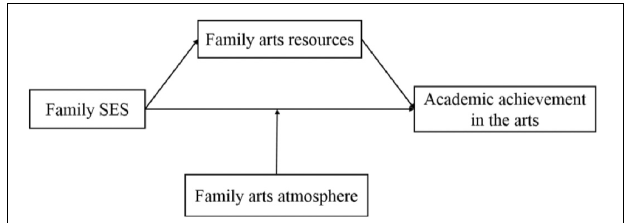
FIGURE 1 | The hypothesized conceptual